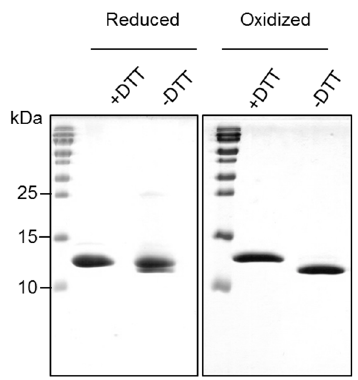
Figure 1. Migration of purified reduced (no disulfide) and oxidized (with disulfide) forms of recombinant Bet v 2 on 18% SDS-PAGE under non-reducing ( − DTT) and reducing (+DTT) conditions. The “reduced” sample contains two species with apparently different molecular weights. The corresponding differences in compactness suggest a partial disulfide bridge formation. Proteins were visualized by Coomassie Blue staining. Please note the faint dimer band at 28 kDa which is present in the “reduced” Bet v 2 sample in the absence of DTT. Table 1. Quantification of cross-linked (S-S) and free-cysteine (S-H) peptides in oxidized (disulfide-bridged) and reduced (no disulfide) forms of Bet v 2 by MS after tryptic digest.